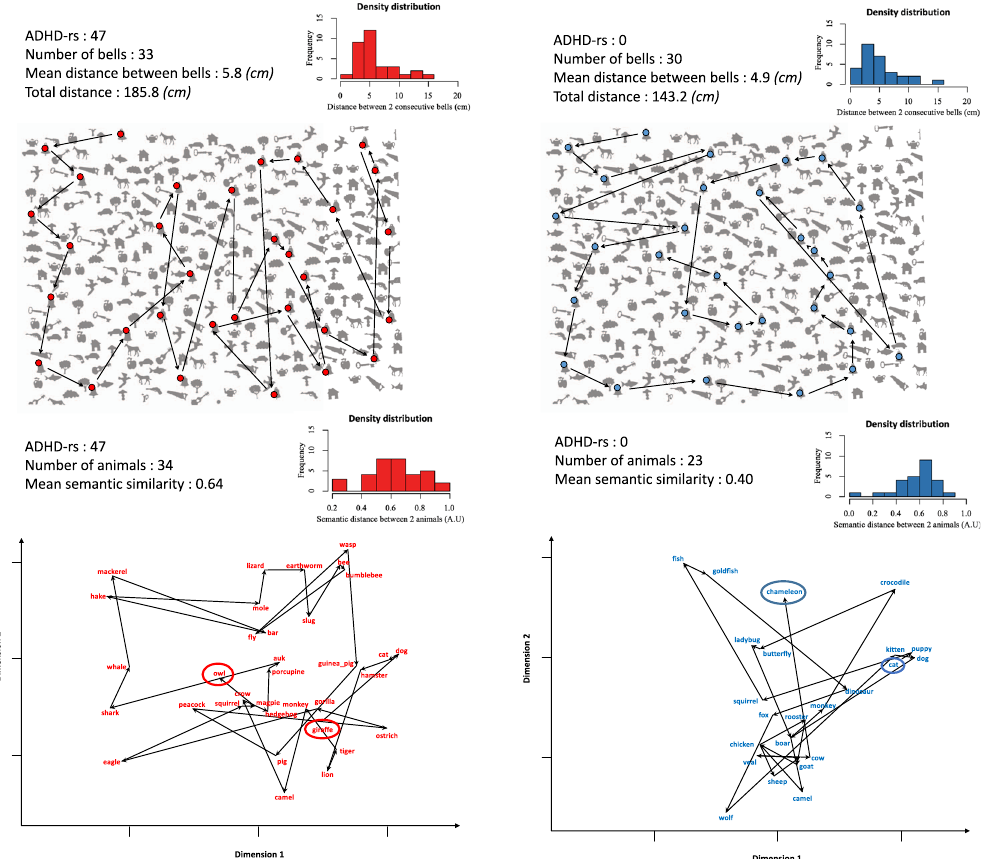
Figure 1. Illustration of search paths in visual (top, with the stimulus sheet overlaid – Bells test by Gauthier et al . 1989 30 ) and semantic (bottom) spaces for two participants, representative of diverse patterns of Inattentive/hyperactive behaviours, one with high (47, left, red) and the other with low (0, right, blue) rating on the ADHD-rating scale. For illustrative purposes only, we here represent the semantic space by means of the t -distributed stochastic neighbor embedding ( t -SNE, tsne package in R 56 ) algorithm for dimensionality reduction, in order to obtain a two dimensions map of the 300 dimensions vectors from the word2vec google.news model 34 . Insets contain the histograms for the distributions of